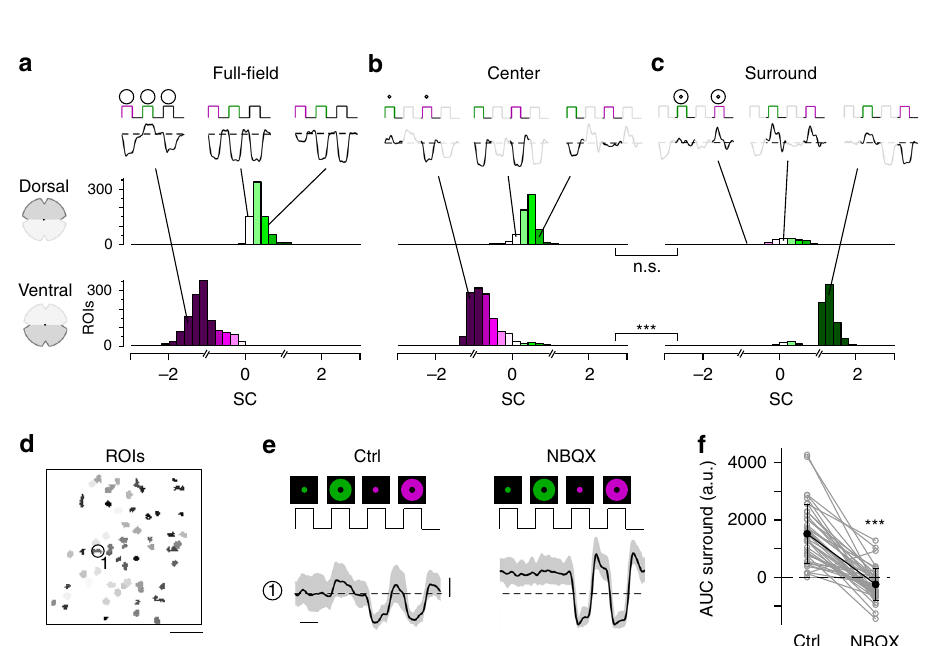
Fig. 1 Imaging chromatic signals from cone axon terminals in the mouse retina. a Sensitivity spectra of mouse S- (magenta) and M-opsin (green) and rhodopsin (black; Rh), with emission spectra of UV (magenta, dotted) and green LED (green, dotted). b Schematic distribution of cone photoreceptors across the mouse retina. Dots and shading represent distribution of true S-cones and co-expression ratio of S- and M-opsin in M-cones, respectively. d dorsal, n nasal, v ventral, t temporal. c Schematic experimental setup for cone recordings. OS/IS outer/inner segment, ONL outer nuclear layer, OPL outer plexiform layer, INL inner nuclear layer, IPL inner plexiform layer, GCL ganglion cell layer. Red and yellow shading illustrate laser and stimulus beam, respectively. d Example scan fi eld (93 × 110 µ m, 3.9 Hz) located in dorsal retina, showing iGluSnFR expression in the OPL (top, scale bar: 20 µ m), correlation image (middle) and ROI mask (bottom). For display, the light artifact on the left side of scan fi elds was cut, resulting in 108 × 128 pixels (instead of 128 × 128). e Cone responses of exemplary ROIs from ( d , bottom) to full- fi eld UV, green and white fl ashes (700 µ m in diameter, scale bar: 1 s). As vertebrate photoreceptors are Off cells, light responses correspond to a decrease in glutamate release. Traces show mean glutamate release with s.d. shading ( n > 10 trials, error bars: 1 s.d.). Dotted line indicates baseline. Traces scaled according to s.d. of baseline. f Cells from ( d , bottom) color-coded according to their SC in response to full- fi eld fl ashes. g Glutamate traces of cells from ( d , bottom) in response to UV and green center (150 µ m in diameter) and surround fl ashes (scale bar: 2 s). h Cells from ( d , bottom) color-coded based on center (left) and surround SC (right). i Correlation image (top) and ROI mask (bottom) for an exemplary scan fi eld located in the ventral retina. j – m Like ( e – h ), but for cells shown in ( i , bottom). Scan fi elds/traces shown in this fi gure correspond to representative examples. In total, we recorded n = 52 scan fi elds in n = 9 mice. For quanti fi cation, see Fig. 2.